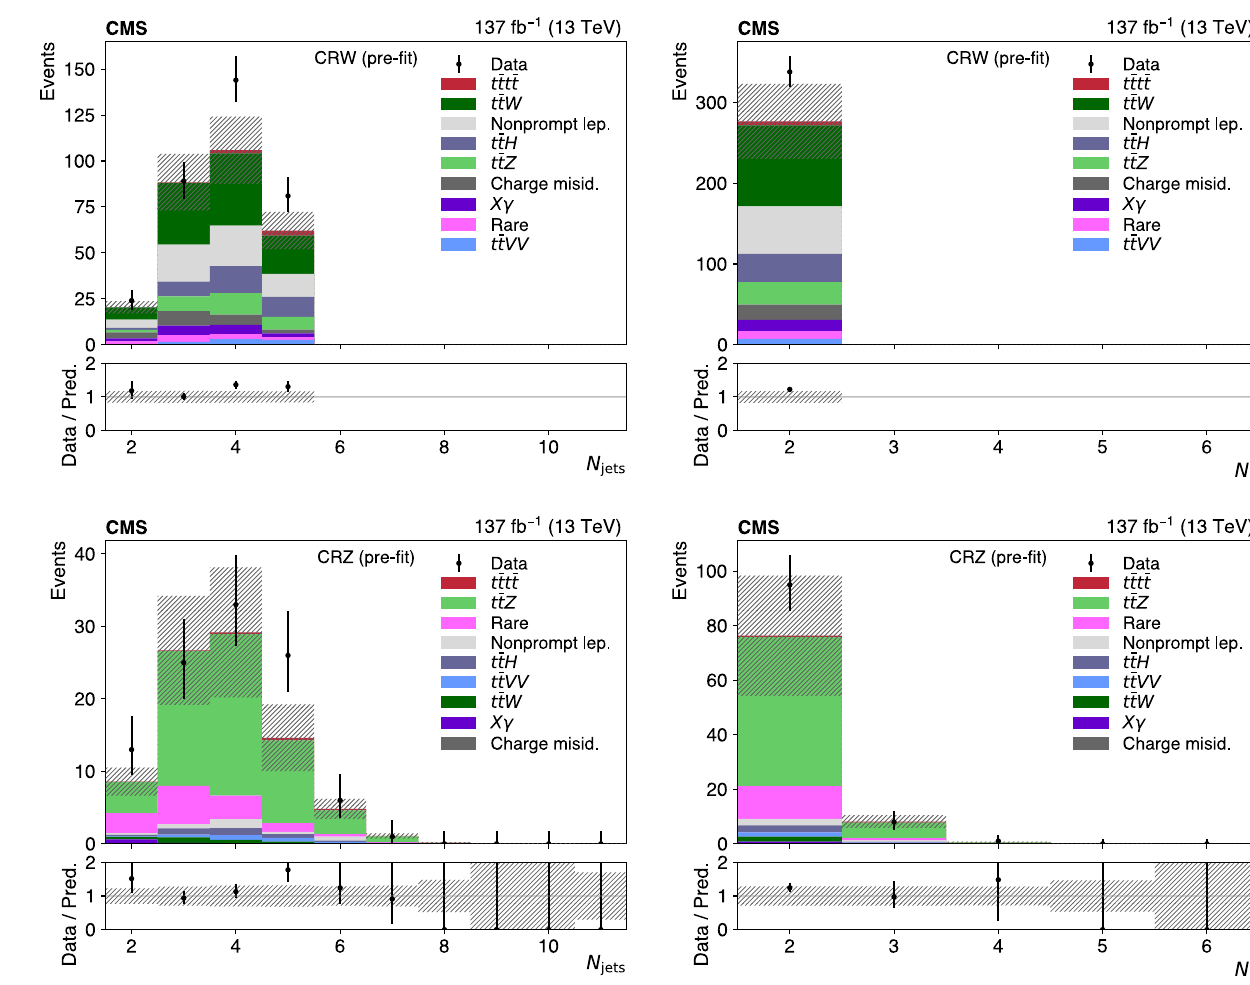
signal assumes the SM cross section from Ref. [1]. The lower panels show the ratios of the observed event yield to the total prediction of signal plus